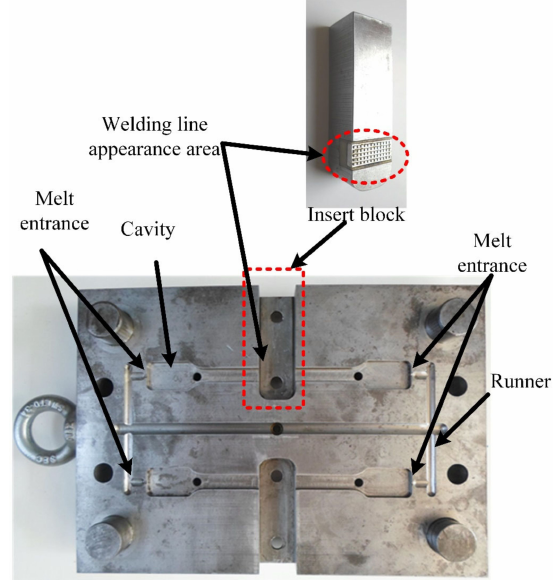
Figure 6. Dimensions of the specimen for a tensile strength test with a mesh structure at the center.